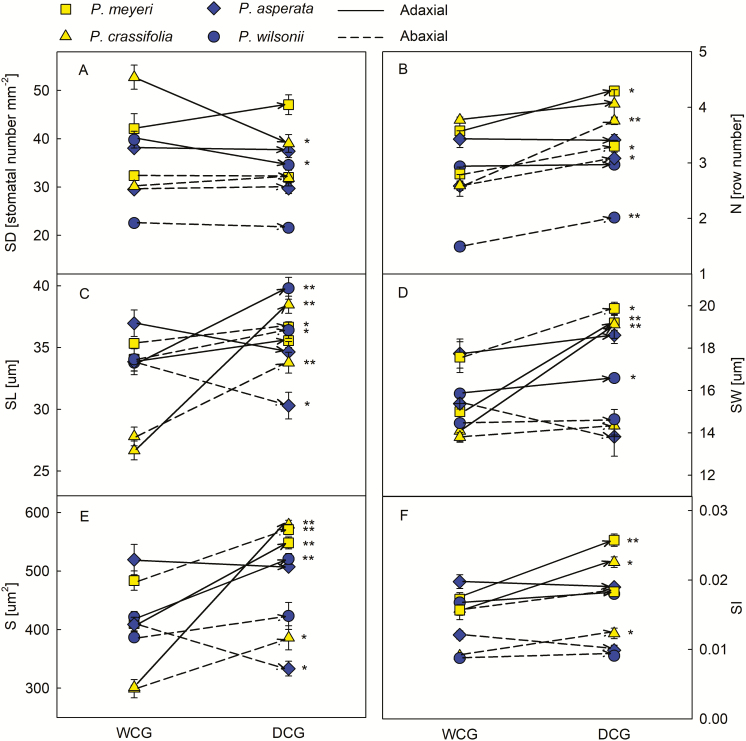
Differences in stomatal traits between WCG and DCG for each species. Yellow symbols indicate the species from the dry habitat and blue symbols indicate the species from the wet habitat. The lines show mean values and standard error of means across three replicates for each measurement, plotted against drought treatments. (A) SD is stomatal density; (B) N is number of stomatal rows; (C) SL is stomatal pore length; (D) SW is stomatal pore width; (E) S is stomatal pore area; (F) SI is stomatal pore index. *P < 0.05 and **P < 0.01.